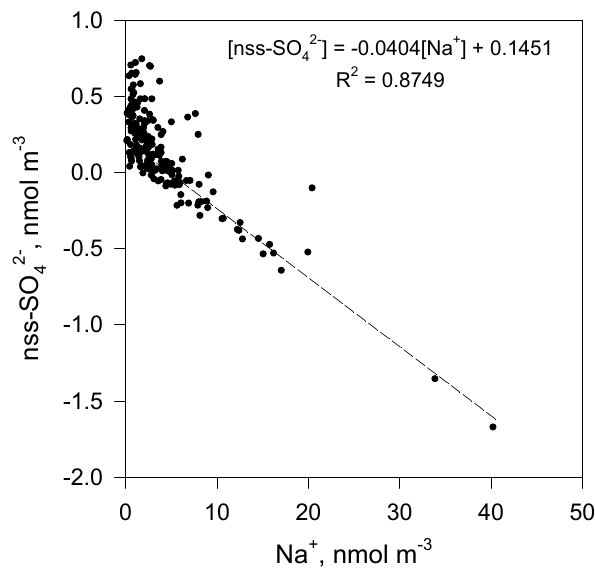
Fig. 8. Relation between Na + and nss-SO 2 − Syowa Station. The concentration of nss-SO 2 − ing Na + and bulk seawater ratio (Wilson, 1975).